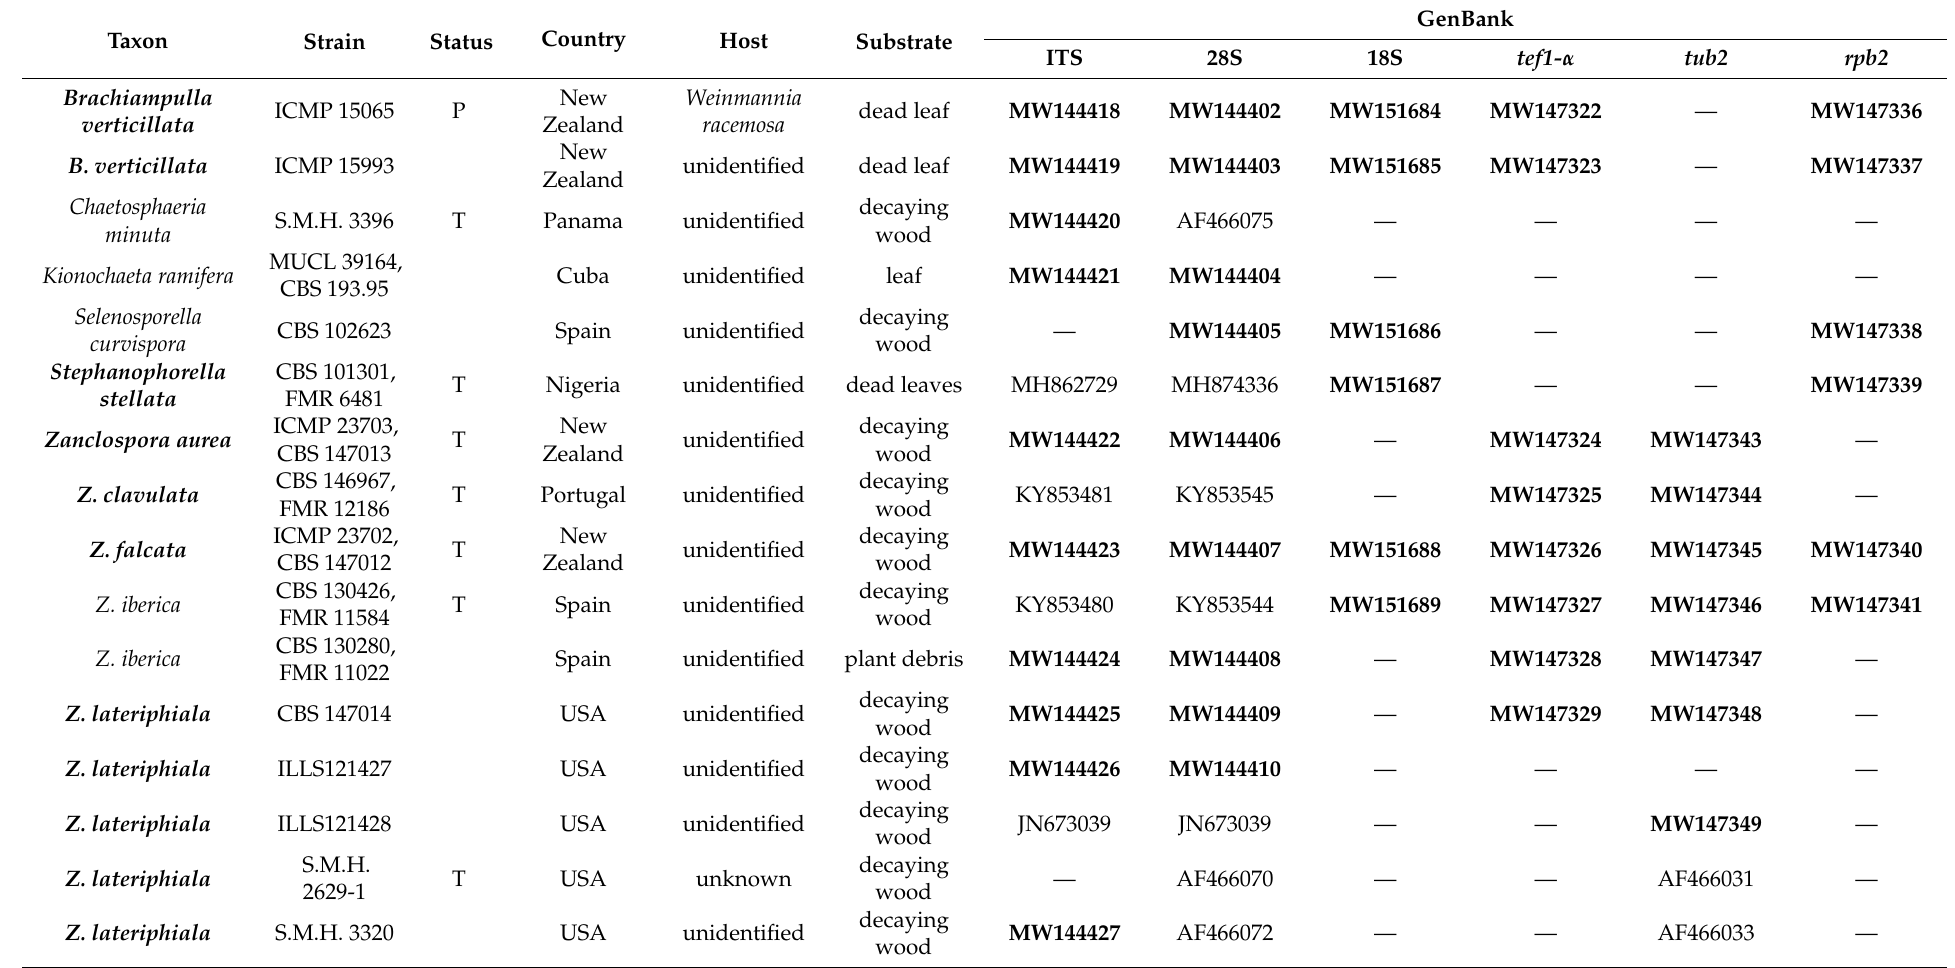
Table 1. Taxa, isolate information and GenBank accession numbers for sequences. New sequences determined for this study and taxonomic novelties are given bold.